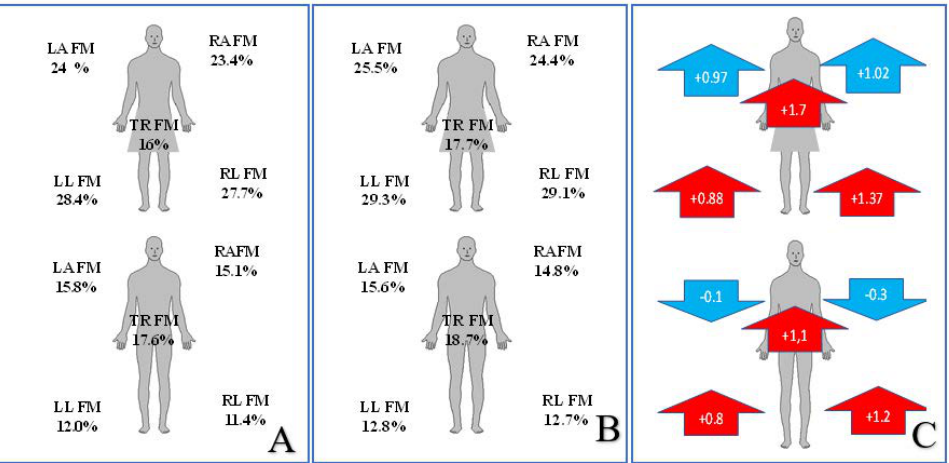
Figure 3. Segmental percentage of the amount of fat mass (FM) depending on gender and study, ( A ) before lockdown study, ( B ) study 02.2021, ( C ) direction of changes and their statistical significance. RL—right leg, LL—left leg, RA—right arm, LA—lest arm, TR—trunk, FM—fat mass, red color p < 0.005.